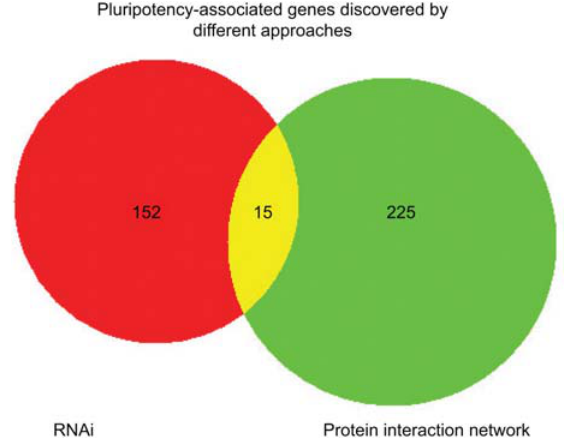
Figure 1 Venn diagram showing the number of pluripotency-asso- ciated genes discovered by different approaches. A total of 167 genes were found in four separate RNAi studies. A total of 240 proteins were found via protein-protein interaction with Oct4, Nanog, Sall4, Tcfcp2l1, Dax1, Esrrb, Rex1, Nac1 and/or Zfp281. Between the two approaches, only 15 genes/proteins are in